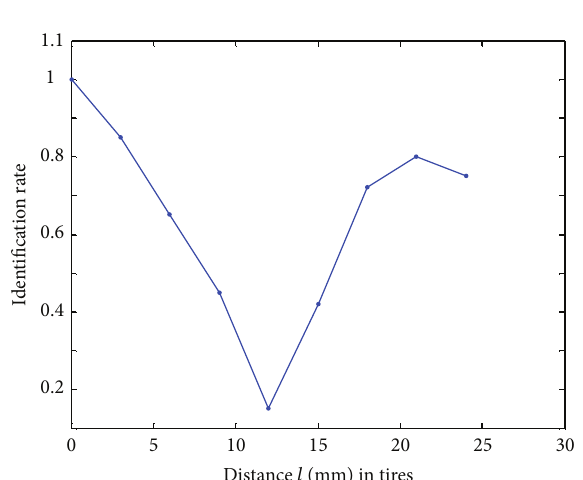
This means the power transmission of tire embedded RFID system declines along with 𝑙 also fluctuates along with 𝑙